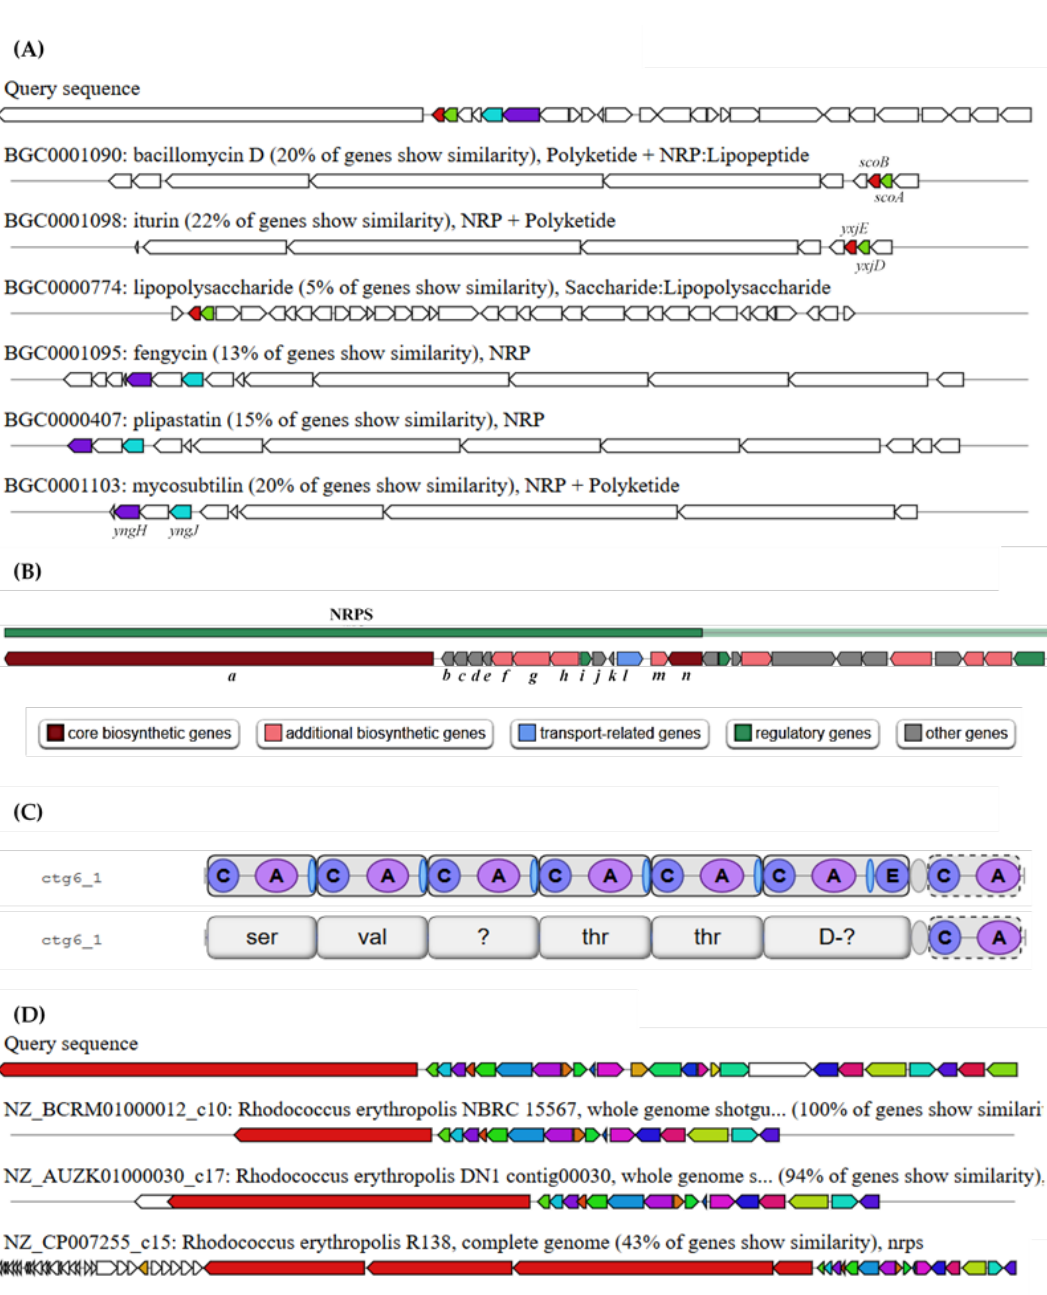
Figure 2. The gene clusters predicted by antibiotics and secondary metabolite analysis shell (anti-SMASH) for the Rhodococcus sp. ADL36 draft genome. ( A ) Homologous known gene clusters; ( B ) schematic representation of the assembly line for the lipopeptide-encoding NRPS-6; ( C ) anti-SMASH prediction of principal locus in NRPS-6 (with and without module domain); ( D ) homologous gene clusters.